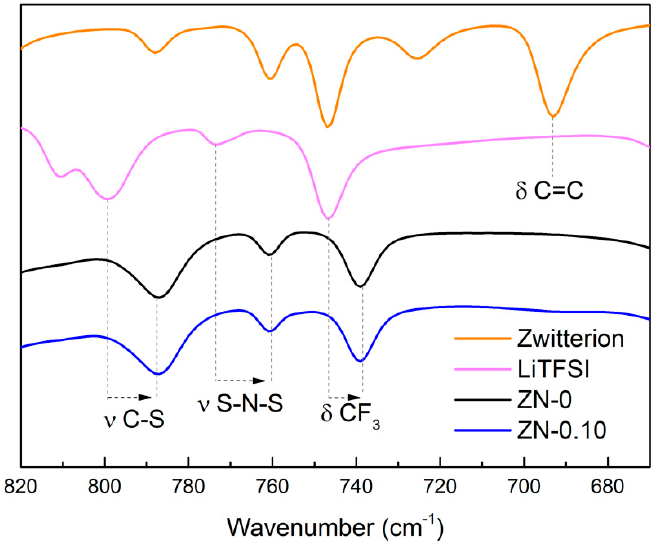
Figure 2. ATR-FTIR of ZN zwitterion, lithium bis(trifluoromethane sulfonyl)imide (LiTFSI) and poly(ethylen glycol) (PEG)-based electrolytes in a wavenumber range from 670 cm − 1 to 820 cm − 1 .